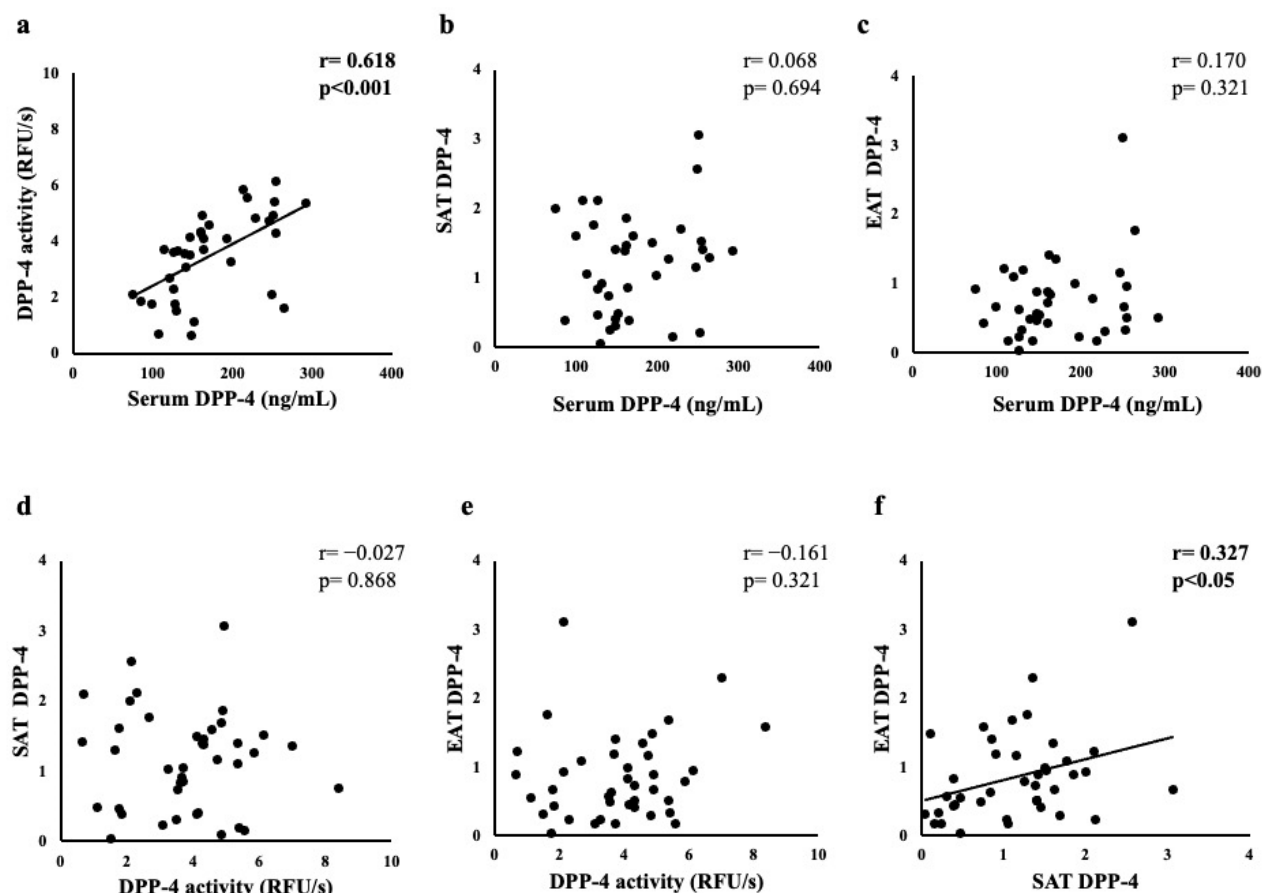
Figure 1. Comparison of dipeptidyl peptidase 4 (DPP-4), adiponectin, and tumor necrosis factor α (TNF α ) expression in subcutaneous and epicardial adipose tissue. ( a ) Expression of DPP-4 in sub- cutaneous and epicardial adipose tissue. ( b ) Expression of adiponectin in subcutaneous and epicar-